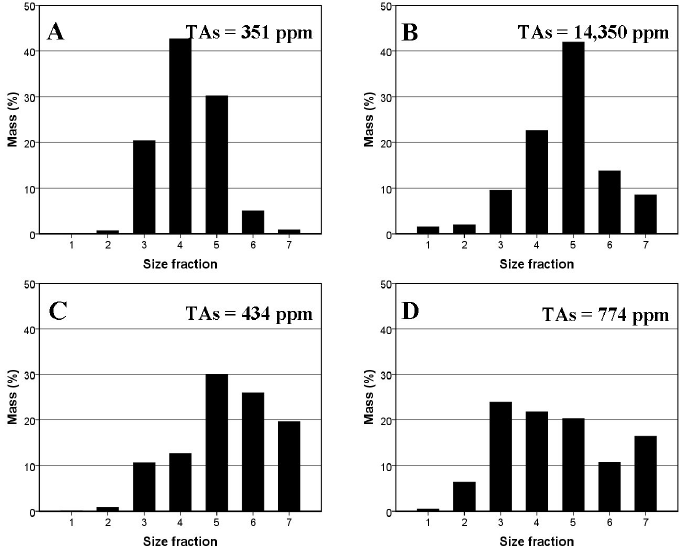
Figure 1. Percentage mass distribution by particle size fraction for historical mine tailings including: ( A ) coarse battery sand; ( B ) red calcine sand; ( C ) fine battery sand; ( D ) composite coarse/fine battery sand. Size fractions Size fractions 1: >2000 µm; 2: 1000–2000 µm; 3: 500–1000 µm; 4: 250–500 µm; 5: 100–250 µm; 6: 53– 100 µm; 7: ≤53 µm. Total arsenic (TAs) concentration (ppm) of each mine waste sample is also shown. (Our results obtained using a modified sieving method protocol described by Kim et al.